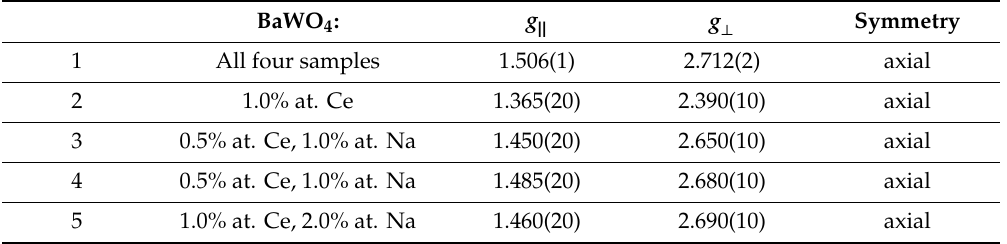
Table 2. The values of g-parameters of Ce 3 + centers with axial symmetry in the BaWO 4 crystal.